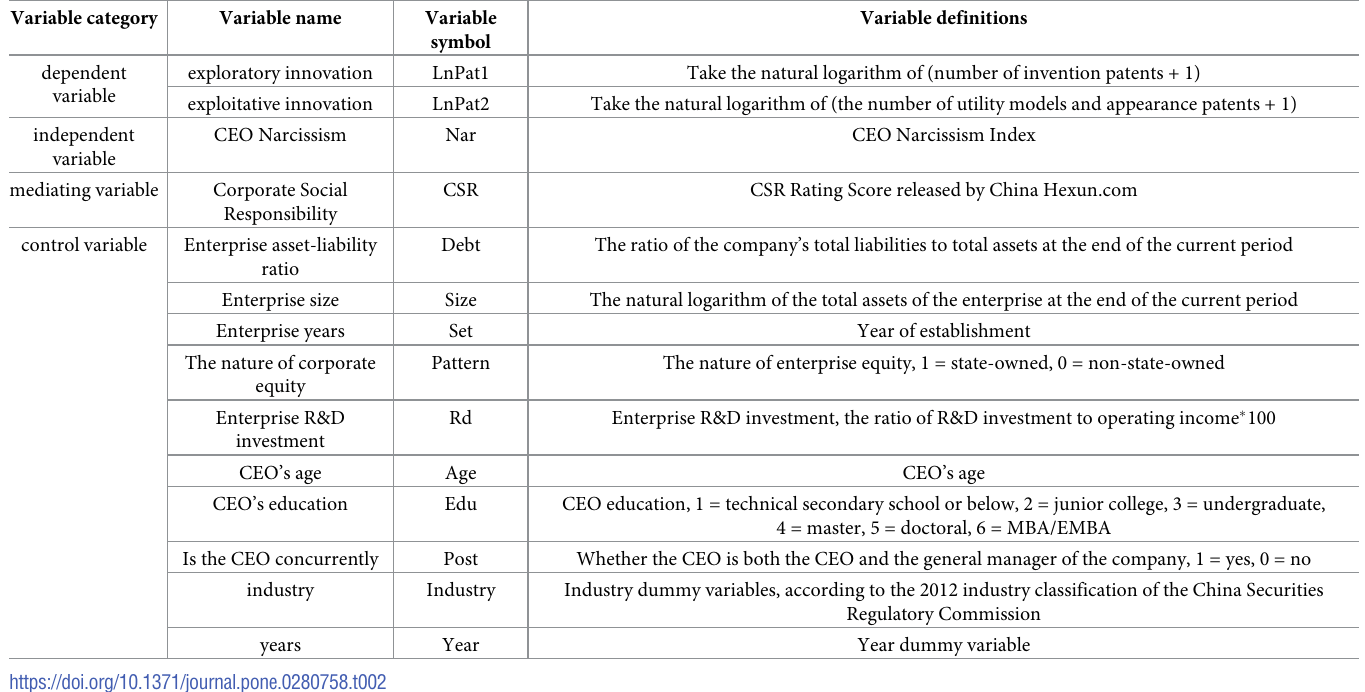
Table 2. Variable